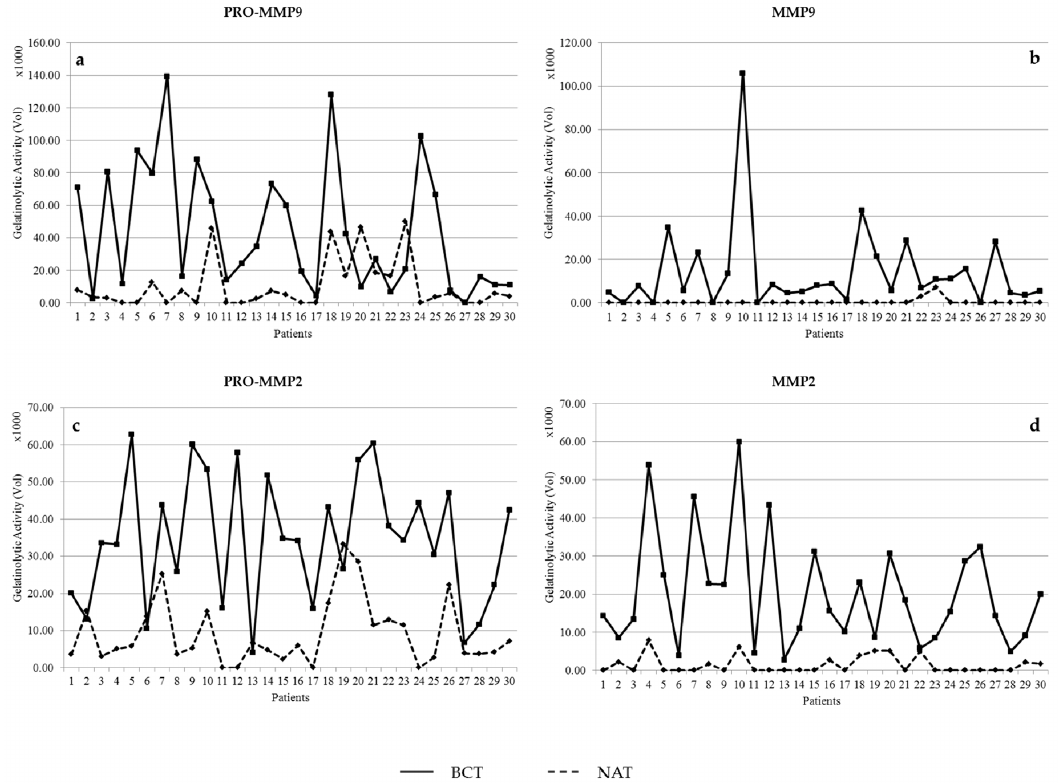
Figure 2. Densitometric profiles of the gelatinolytic bands corresponding to pro-MMP-9 ( a ), MMP-9 ( b ), pro-MMP-2 ( c ), MMP-2 ( d ) in the 30 breast cancer tissues compared to the respective non-tumoral adjacent tissues. Note that the active forms of both the MMPs are absent or rarely present in the non-tumoral tissues.